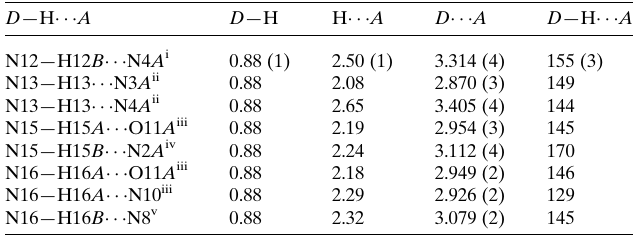
Table 4 Hydrogen-bond geometry (A˚ , (cid:4) ) for 4 .